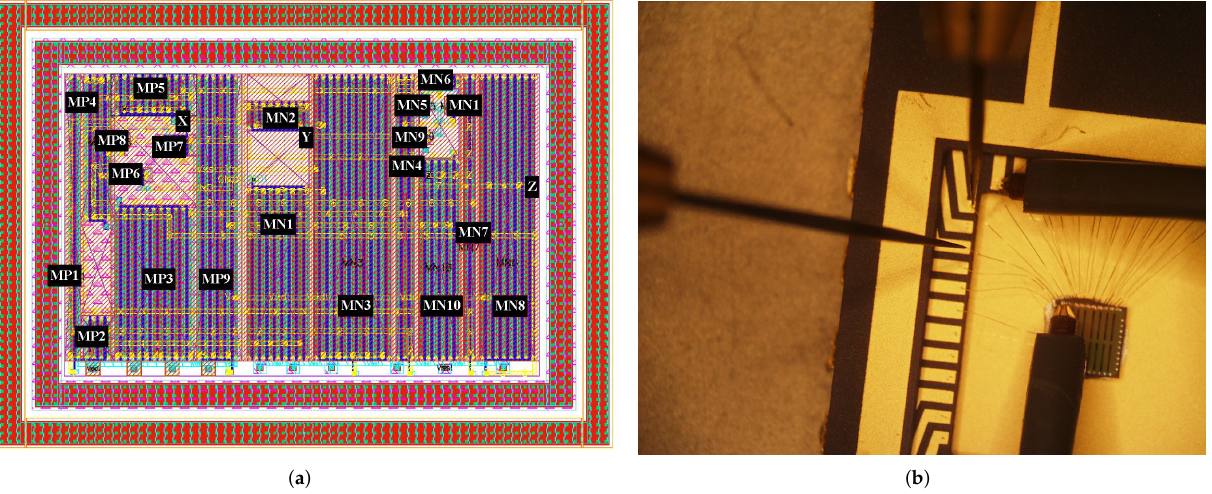
Figure 9. Layout used for the DCVC circuit in 65 nm CMOS technology; ( a ) designed layout and ( b ) encapsulated